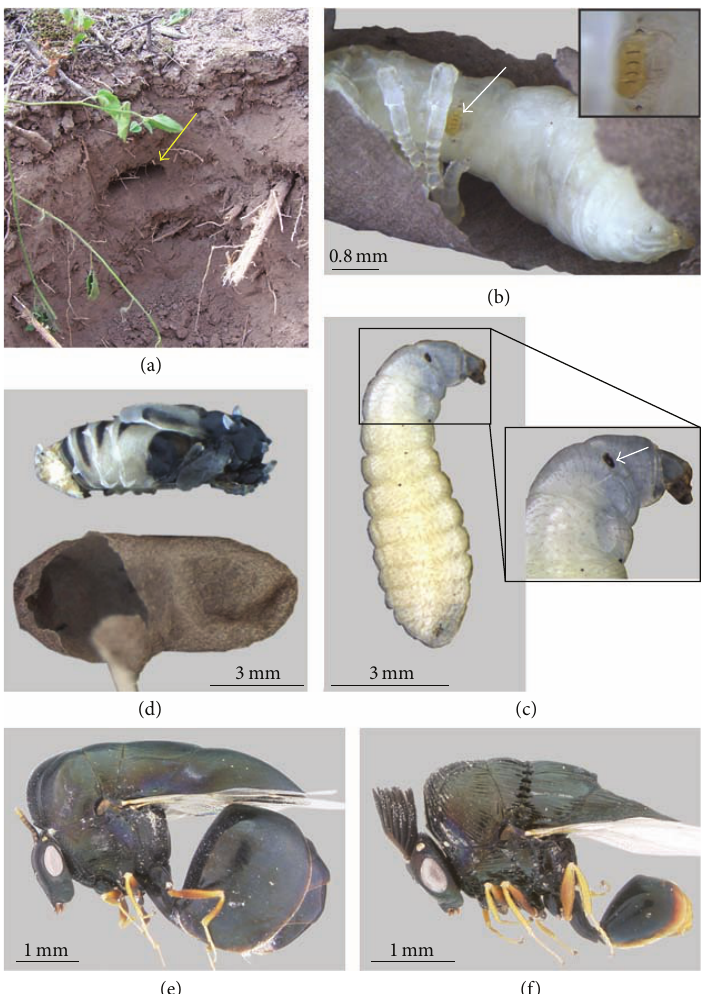
Figure 2: Biology and immature stage of D. platycerus : (a) brood chamber (indicated); (b) prepupa parasitized (2nd instar larva indicated and magnified); (c) ant larva parasitized (attached planidium magnified and indicated); (d) pupa extracted with ant cocoon (female, lateral). Galearia latreillei : (e) habitus (female); (f) habitus (male). Figures 2(a), 2(b), 2(c), and 2(d) are extracted from [22].